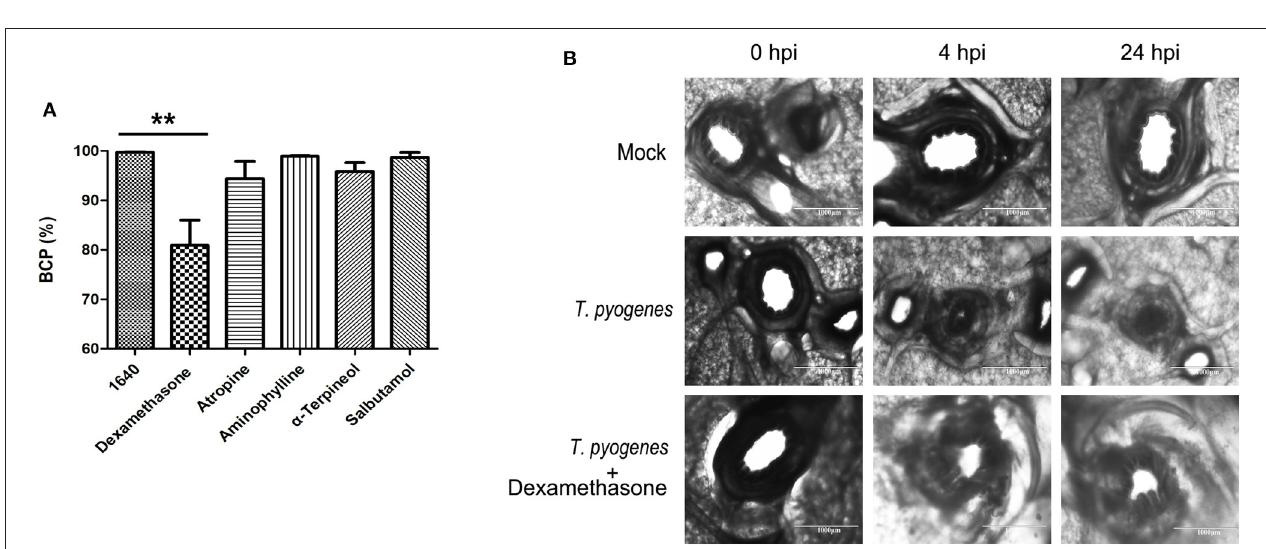
FIGURE 6 | Therapeutic effect of bronchodilators on bronchoconstriction in infected PCLS cultures. (A) The BCP after five common bronchodilators were used to treat bronchoconstriction resulting from T. pyogenes infection. Results are expressed as means ± S.D., and significance was determined using one-way ANOVA and the Tukey multiple-comparison test. ** p < 0.01. (B) Therapeutic effect of dexamethasone on bronchoconstriction in PCLS cultures infected with T. pyogenes